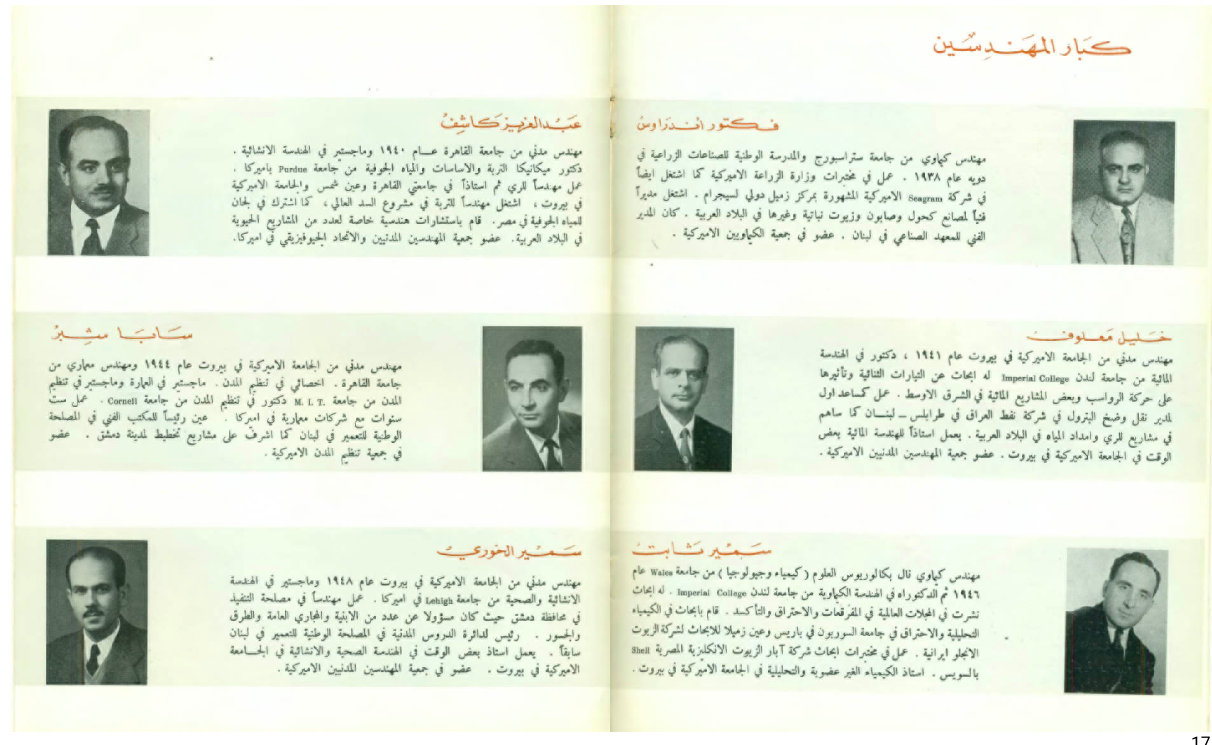
biographies. Source: Arabic print of ACE’s pamphlet, (1959) courtesy to Shiber Archive, Washington, DC. ©